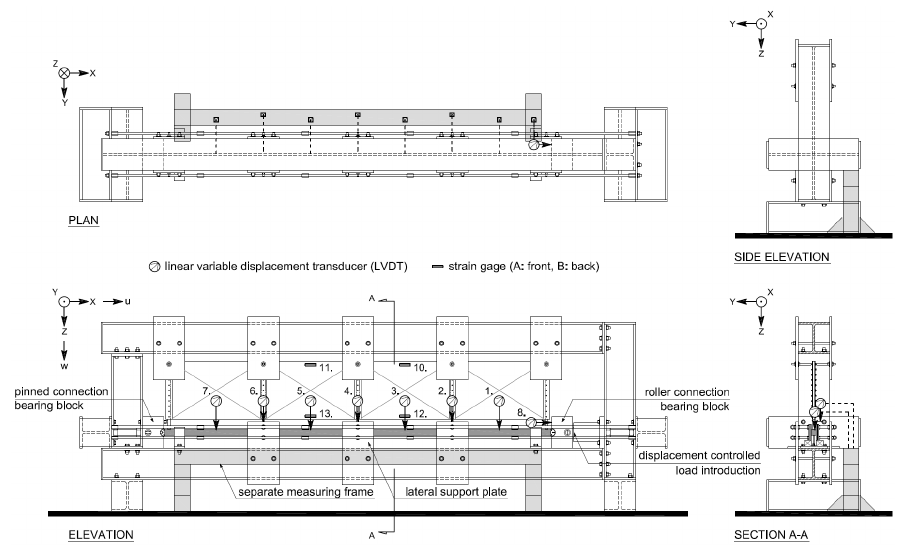
Figure 6: Overview of the test rig and position of the specimen, measurement locations and numbering.